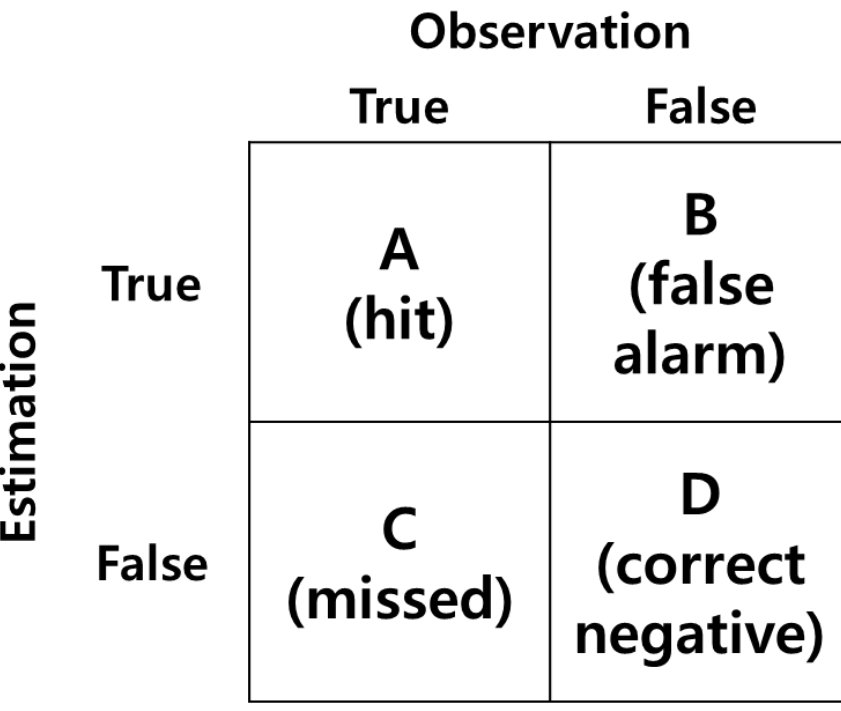
Figure 5. Contingency table used to estimate visibility detection performance.